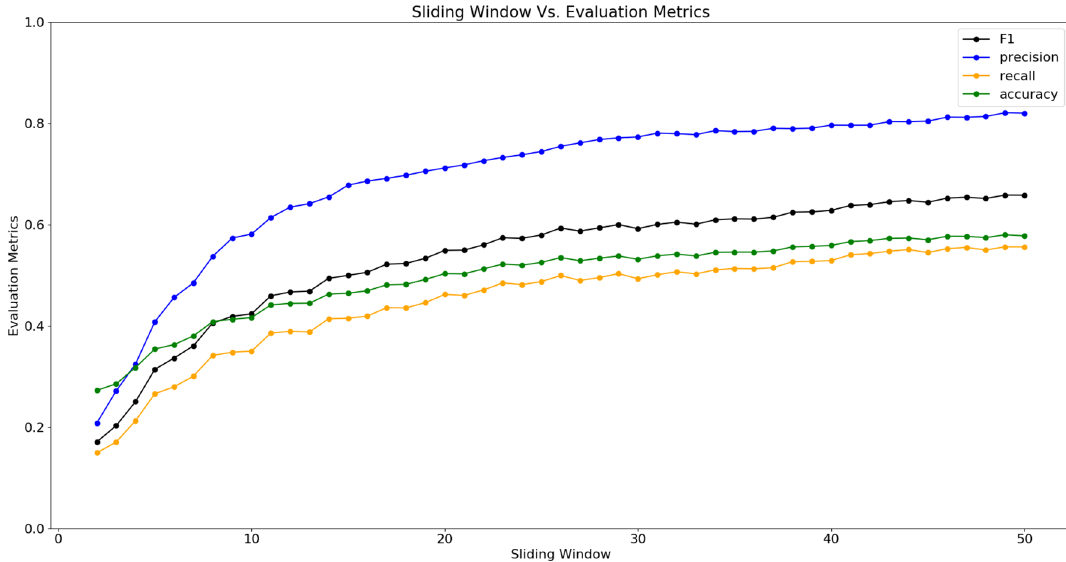
Figure 7. Sliding window versus evaluation